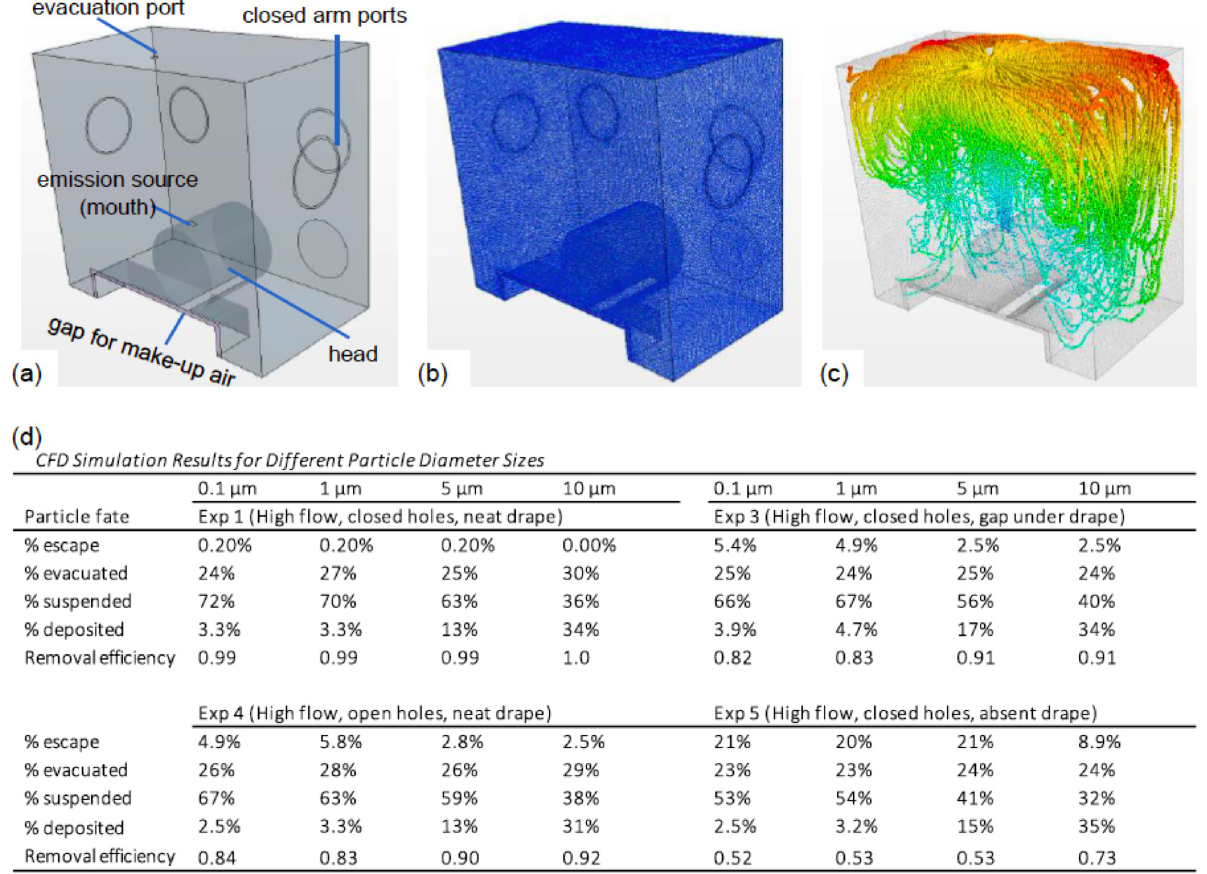
Fig 4. ABCD CFD simulations. (a) Simulation 3D geometry of ABCD details a supine patient exhaling particles at average breathing rate of 10 L/ min. Patient head and shoulders are contained within the device; evacuation flow located along the top of the device and there is a gap for make-up air to flow in through the bottom of the device. Also shown are (b) CFD mesh with 800,000 cells; and (c) representative results of simulation for 0.1 μ m particle size emissions where green/blue color indicates short duration (age of particle) after emission and orange/red color indicates long duration (red shows particles trapped suspended in corner of ABCD). (d) Particle fate in ABCD, where CFD simulations demonstrate increasing percentage of suspended particles and decreased percentage of deposited particles in the device as particle size decreases.